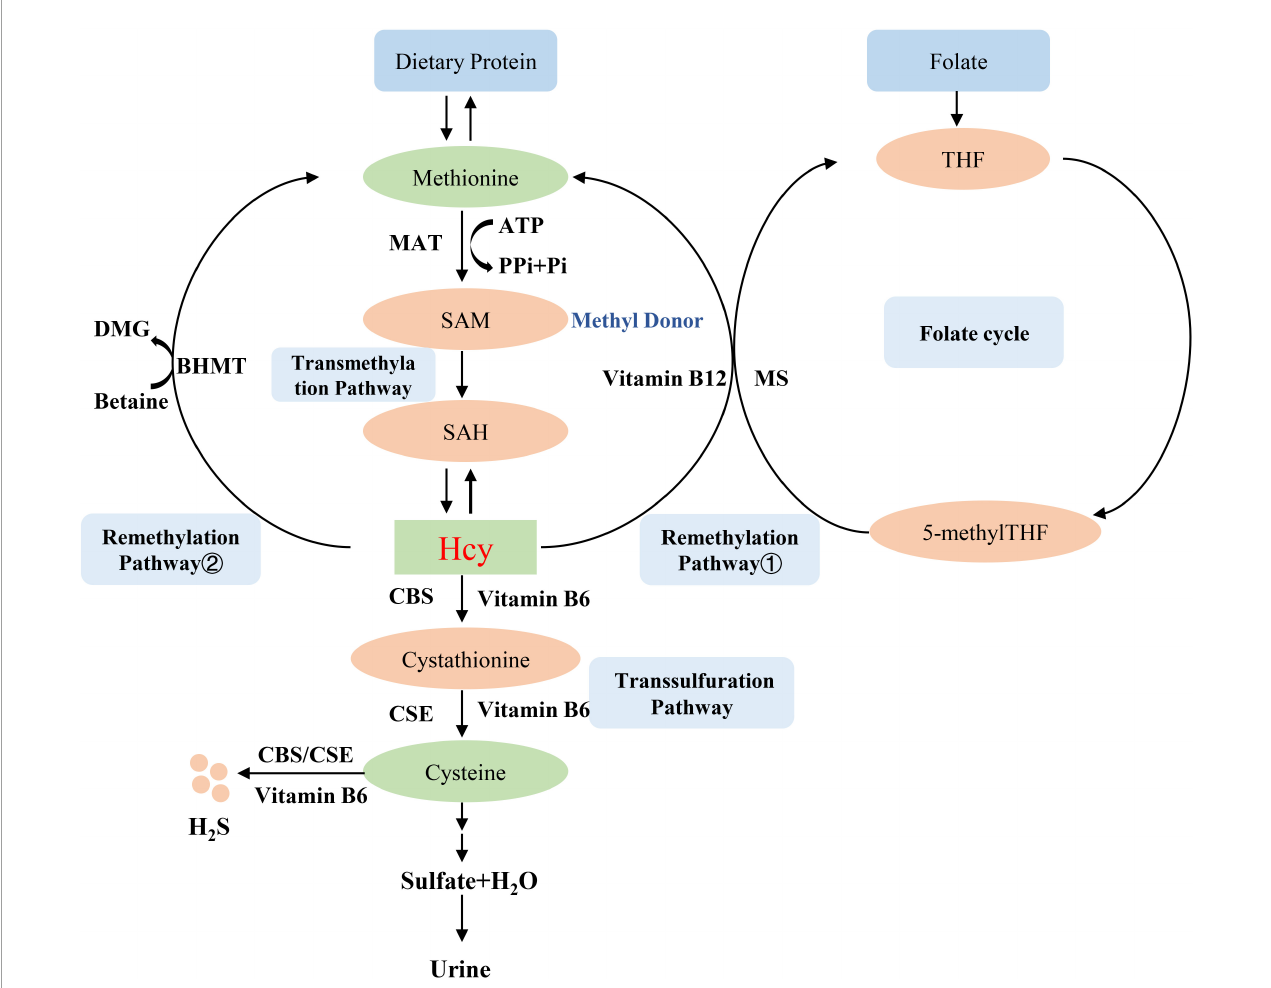
FIGURE1 Homocysteine metabolism. MAT, methionine adenosyltransferase; SAM, S-adenosylmethionine, AdoMet; SAH, S-adenosylhomocysteine, AdoHcy; CBS, cystathionine β -synthase; BHMT, betaine-homocysteine methyltransferase; MS, methionine synthase; THF, tetrahydrofolate; 5-methylTHF, 5-methyltetrahydrofolic acid; CSE,